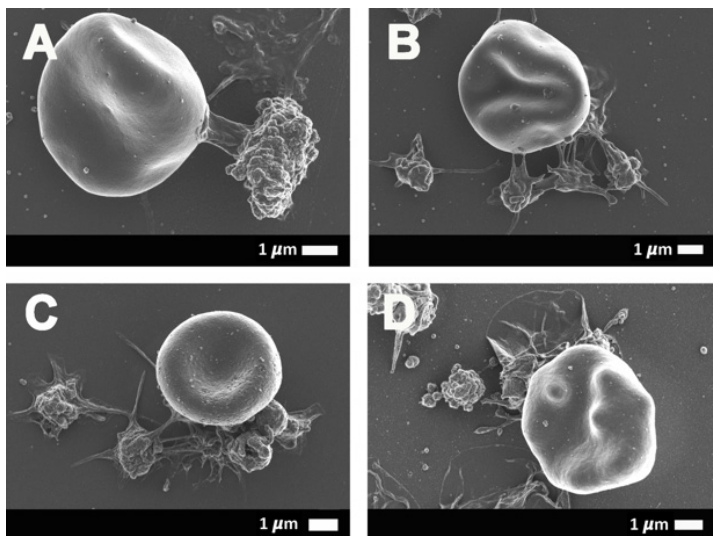
Figure 4. ( A – D ) Representative scanning electron micrographs of the interaction between the erythrocytes and platelets of COVID-19-positive patients.